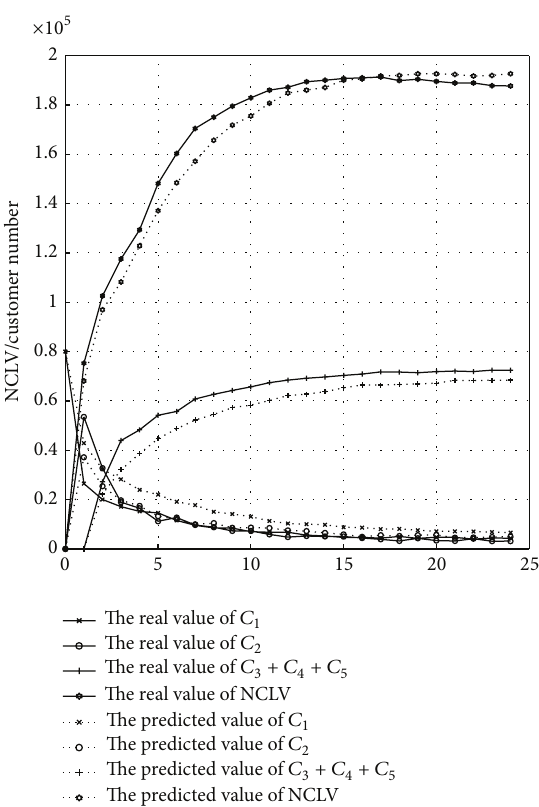
Figure 12: The comparison results for the test case with minimum